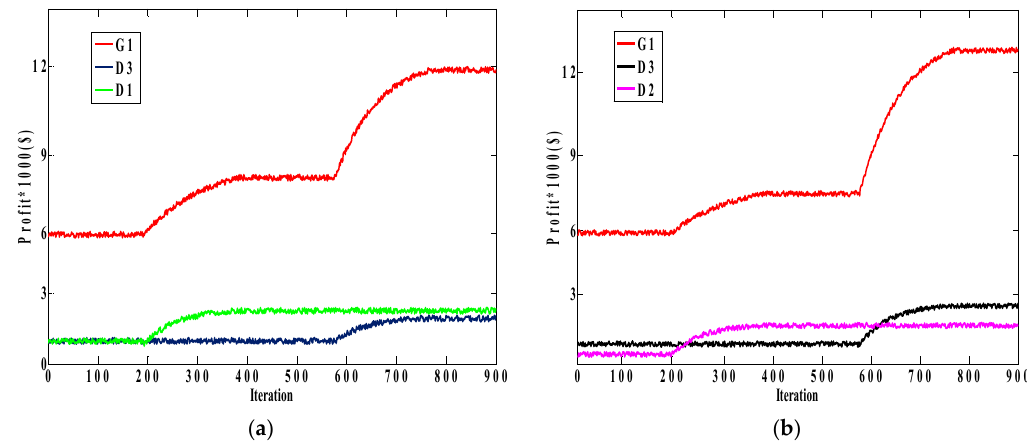
Figure 9. Profit functions of participants in two cases: ( a ) G1, D1, and D3 in Case A; ( b ) G1, D2, and D3